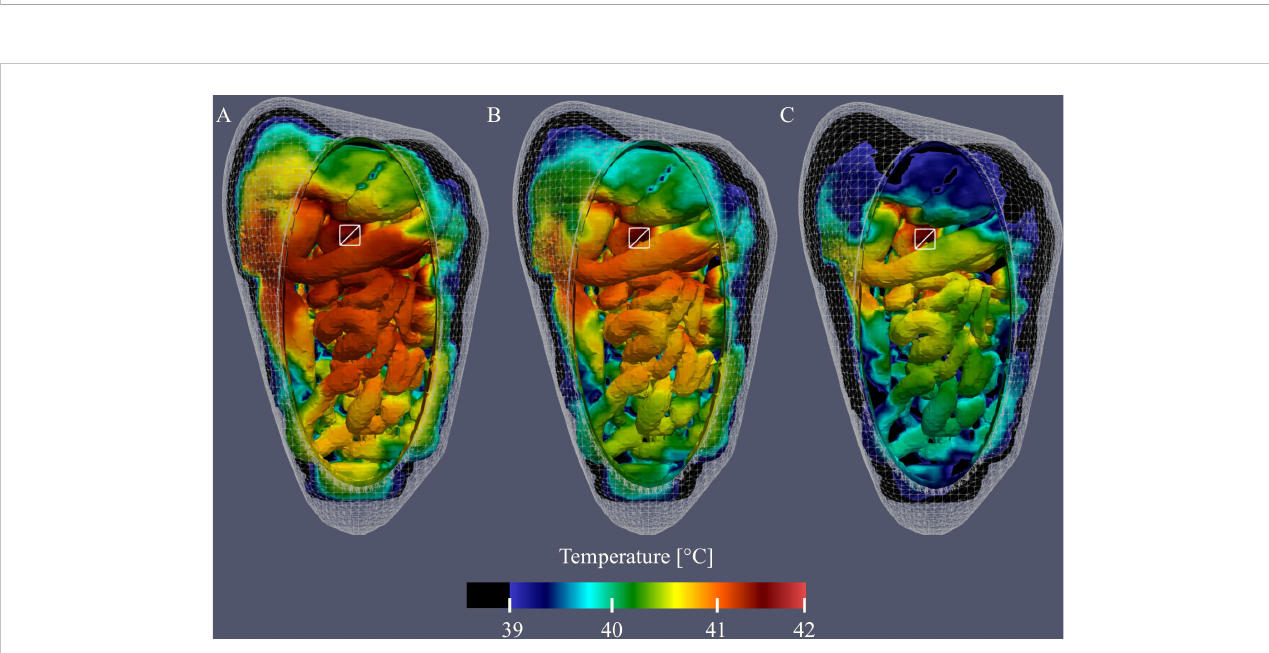
FIGURE 7 Visualization of the simulated thermal distributions and the effect of changes in fl ow rate on the distribution. White squares denote the location of the in fl ow catheter and temperatures below 39°C are black. The thermal distribution of case #1 (A) shows that a high fl ow rate at one location results in high temperatures near the in fl ow and surroundings. Reducing the fl ow rate to 800 mL/min (B) and 600 mL/min (C) results in lower temperatures, most notably in distant